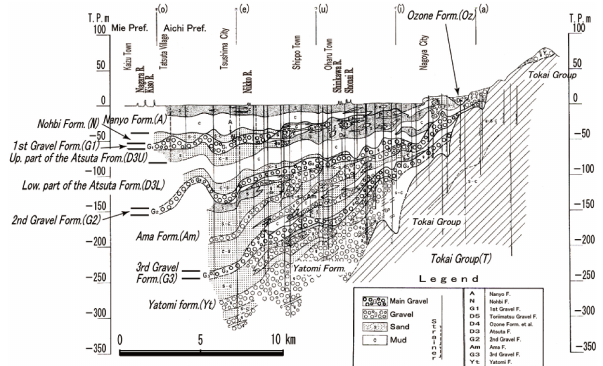
Figure 4. E-W geologic profile of the Nohbi Plain modified from Kuwahara